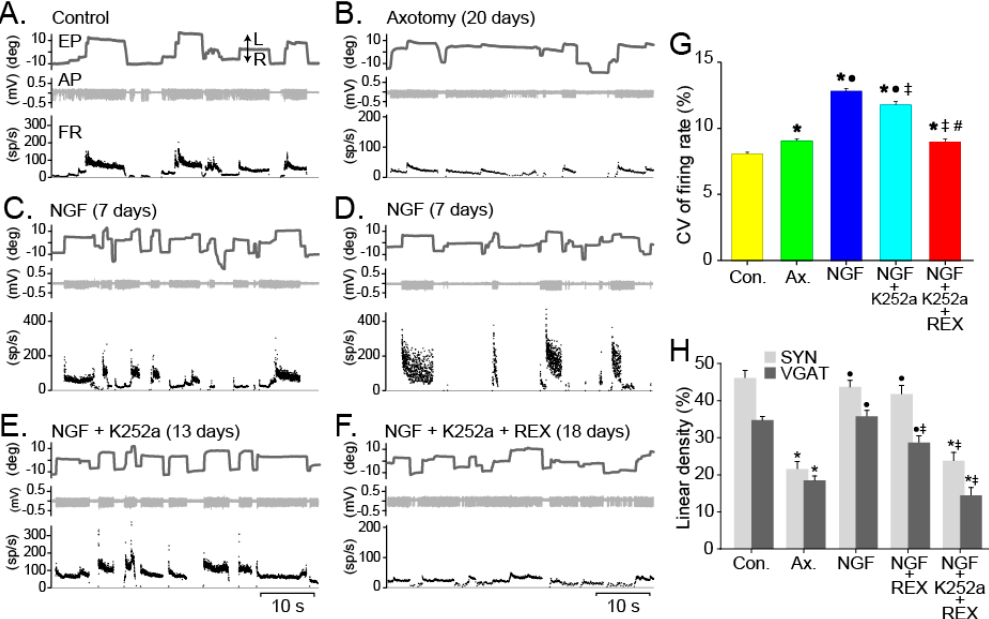
Figure 7. Effects of NGF and NGF receptor blockers on the discharge pattern of axotomized abducens motoneurons: ( A ) Firing rate (FR) profile of a control abducens motoneuron recorded during spontaneous eye movements (EP, eye position). The single-unit discharge of action potentials (AP) is shown in the middle trace. L and R are left and right directions of movement, respectively; ( B ) Same as in ( A ), but for a motoneuron recorded 20 days after axotomy. Note reduced firing during both saccades and spontaneous fixations; ( C , D ) NGF treatment causes recovery of the burst-tonic firing pattern; however, the discharge variability increased during eye fixations; ( E ) Motoneurons treated with K252a still showed some of the effects produced by NGF, indicating that part of the effects of NGF could be mediated also via the p75 NTR ; ( F ) Motoneurons treated with K252a and the p75 NTR blocker REX demonstrated an axotomy-like firing profile although they were firing continuously; ( G ) Comparison of the coefficient of variation (CV) of firing rate in the interval 30–80 sp/s. Note that NGF treatment dramatically increased the firing variability, while blockade of TrkA receptors partially decreased variability, and blockade of both p75 NTR and TrkA receptors restored firing variability to axotomy levels (ANOVA test, Holm–Sidak method for pairwise multiple comparisons, p < 0.05). Symbols indicate significant differences with respect to: *, control; •, axotomy; ‡, NGF treatment; and #, NGF+K252a treatment; ( H ) Linear density of synaptophysin-IR (SYN) and VGAT-IR boutons over the somatic perimeter of motoneurons changes after axotomy and the different treatments. Bars represent mean ± SEM for 17–38 motoneuronal profiles in each group. Asterisks indicate differences with control, dots with axotomy, and double crosses with the NGF group. Modified from [106].